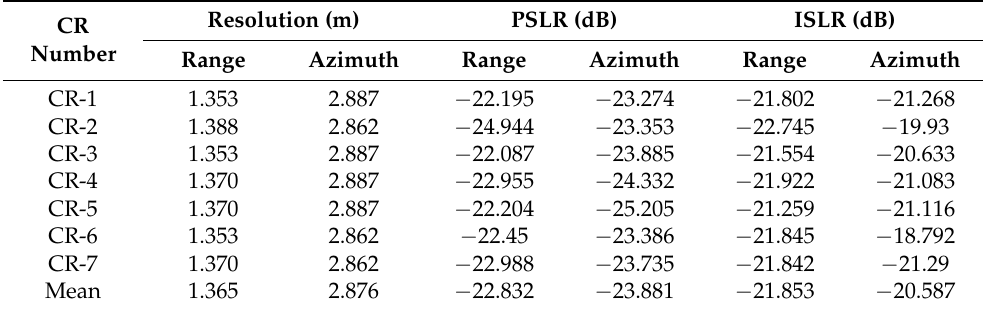
Table 3. Image quality parameters from each CR for UFS mode data on 12 May.